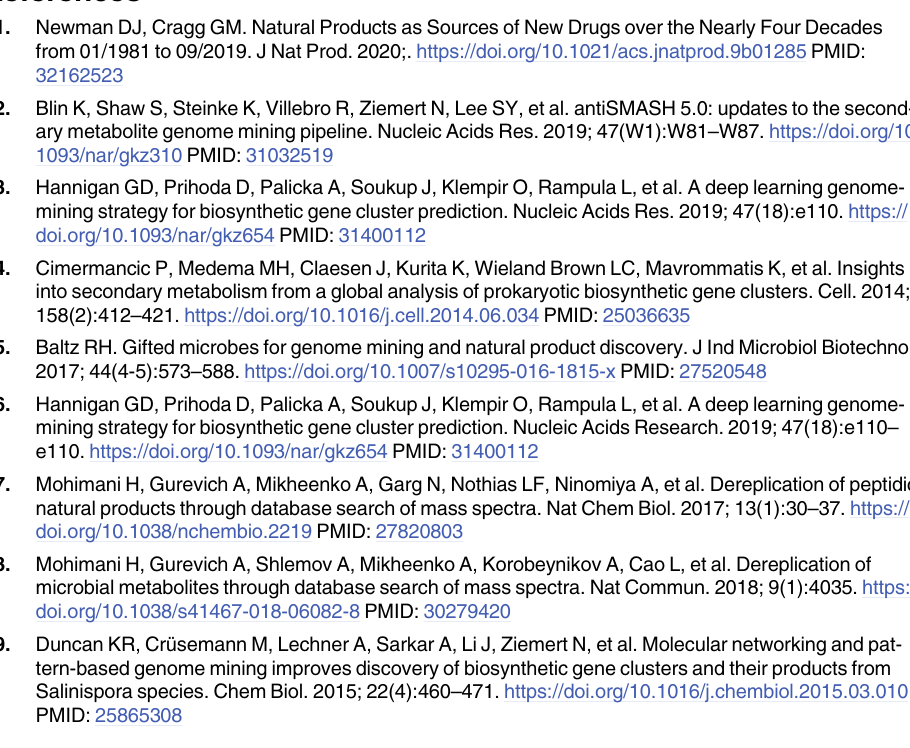
S4 Data. High-scoring links from the Gross data